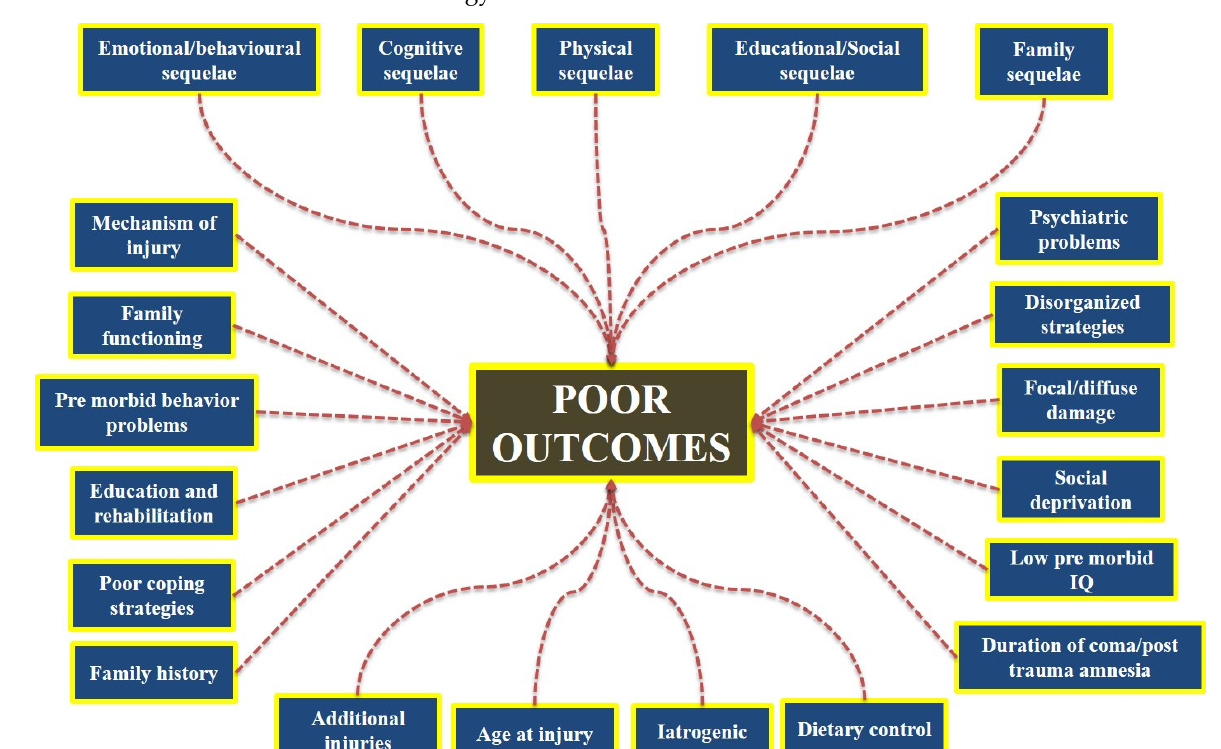
Figure 2. Poor outcomes post-ABI. A variety of parameters related to the ABI mechanism play a role in predicting the outcome. ABI can develop as a result of a stroke or disease or an iatrogenic cause, and there is some indication that those who suffer from a head injury are a self-selecting group, with poor attention, impulsivity, and overactivity being associated with poor road-crossing skills. These may interact with other premorbid characteristics that are predictors of poor post-injury prognosis.